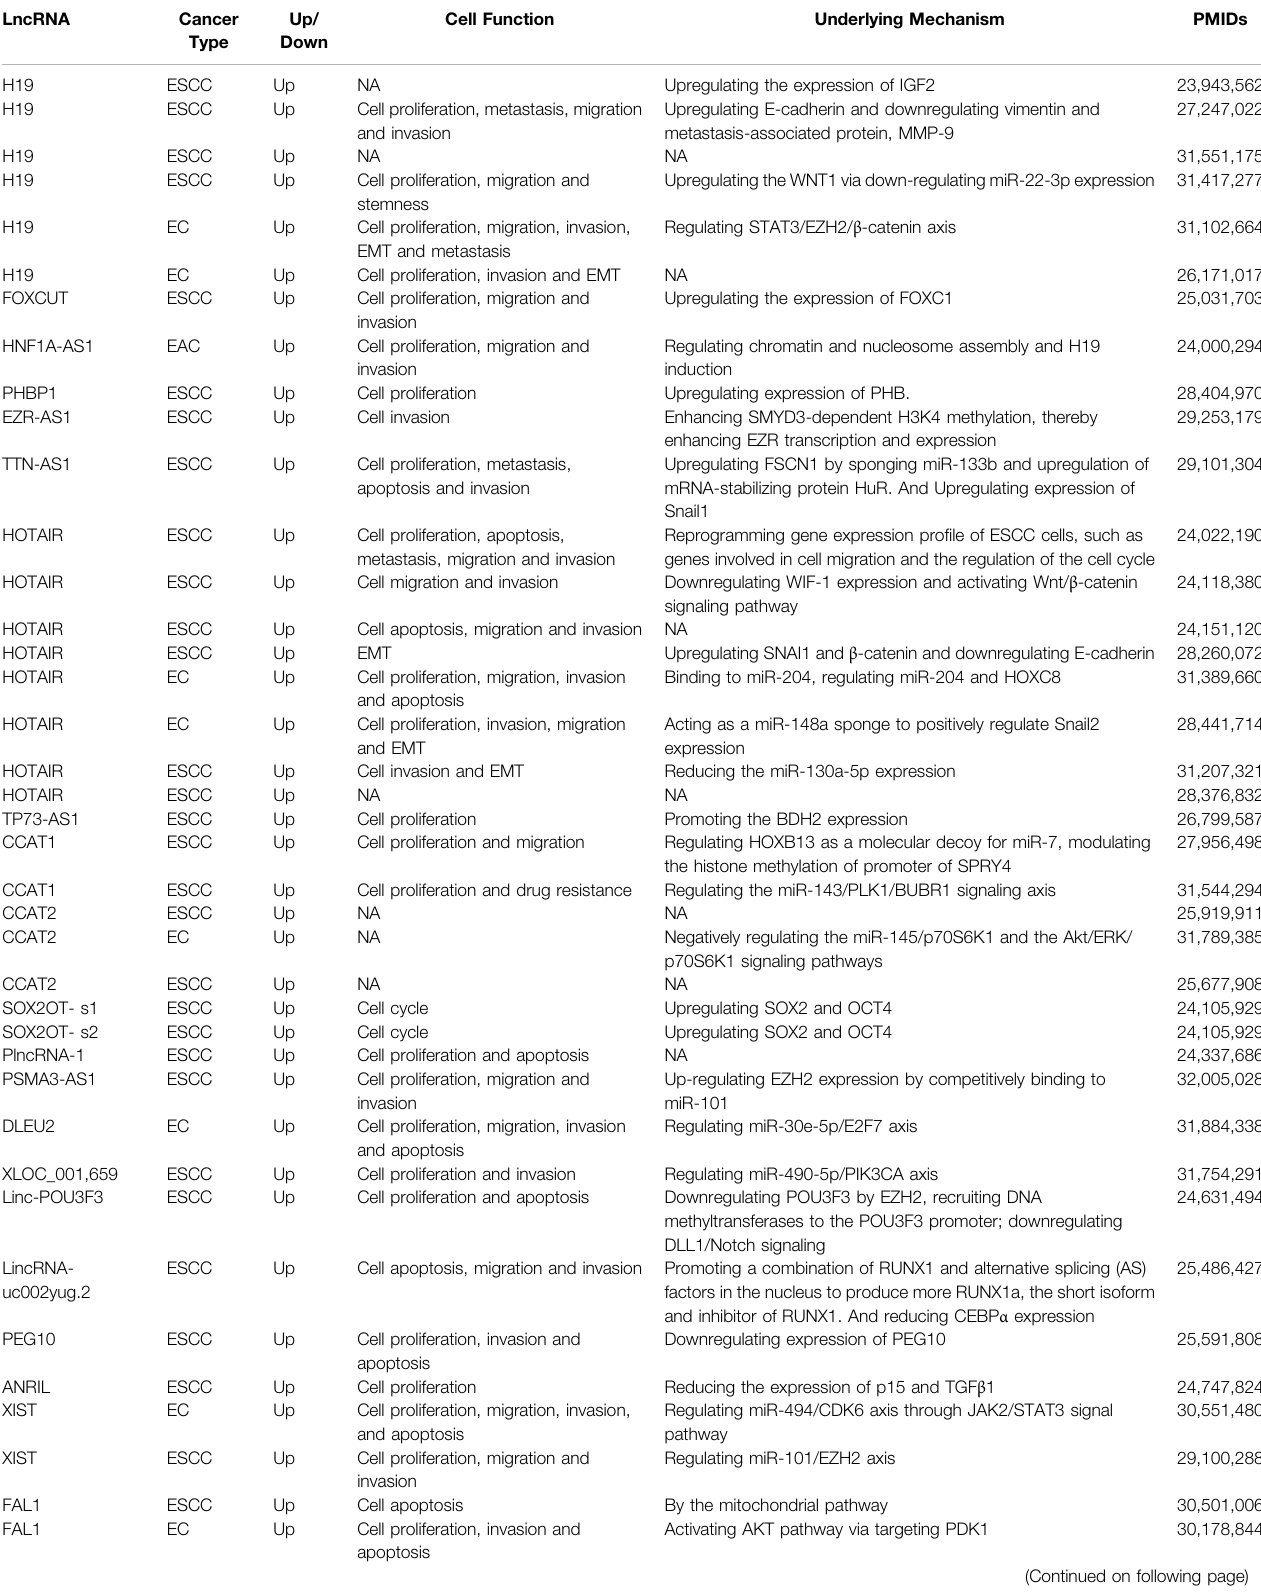
TABLE 1 | EC-associated oncogenic lncRNAs.